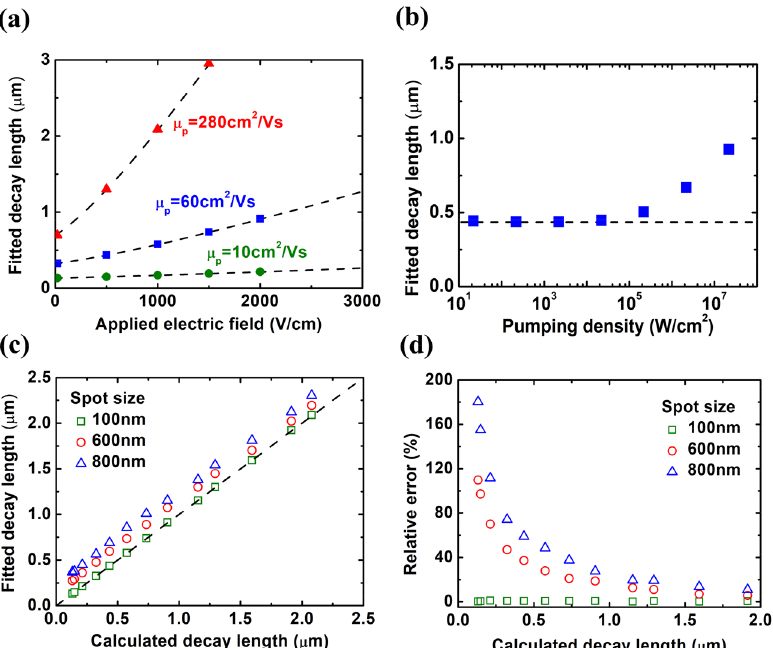
Figure 4. ( a , b ) Fitted decay length extracted from scanning photocurrent profiles with varied ( a ) applied electric field and ( b ) pumping density. The dashed line corresponds to the calculated decay length obtained from Eq. (2). ( c ) The relations between fitted decay length and calculated decay length with varied laser spot size. The x = y line is shown as the dashed line for clarity. ( d ) The relative error calculated in ( c ) with varied laser spot